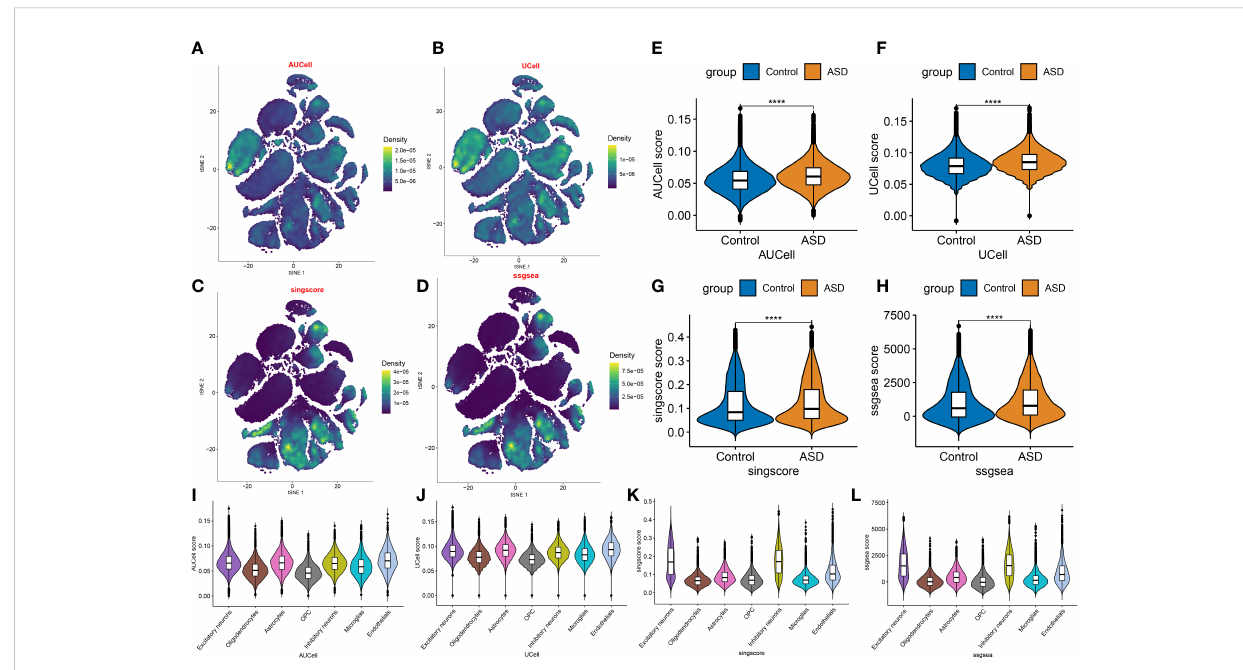
FIGURE 3 Evaluation of necroptosis activity based on snRNA-seq data. (A – D) The AUCell (A) , UCell (B) , singscore (C) , and ssgsea (D) algorithms depicting the distribution of necroptosis activity at each cell based on the tSNE plots. (E – H) Violin plots exhibiting the differences in necroptosis score between control and ASD groups on the basis of the AUCell (E) , UCell (F) , singscore (G) , and ssgsea (H) algorithms. **** p < 0.0001. (I – L) Violin plots exhibiting the differences in necroptosis score among various cell subtypes on the basis of the AUCell (I) , UCell (J) , singscore (K) , and ssgsea (L)